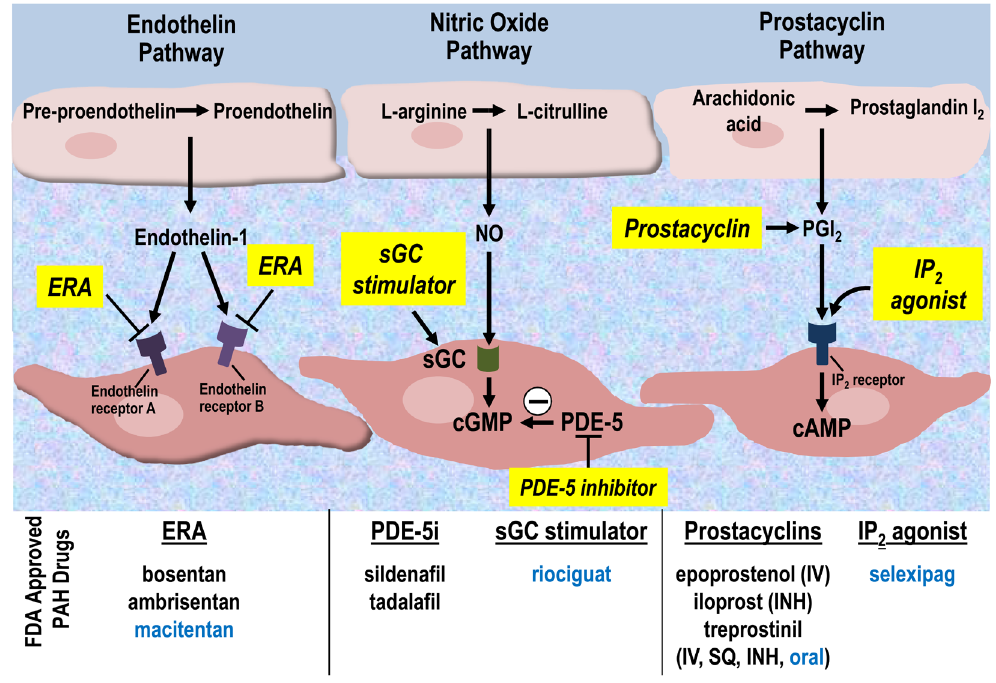
Figure 1. Pathways targeted in current therapies for pulmonary arterial hypertension. Newly approved therapies are listed in blue. cAMP, cyclic adenosine monophosphate; cGMP, cyclic guanylate monophosphate; ERA, endothelin receptor antagonist; FDA, US Food and Drug Administration; INH, inhaled; IP , prostacyclin receptor 2; IV, intravenous; NO, nitric oxide; PAH, pulmonary arterial hypertension; PDE-5, 2 phosphodiesterase-5; PDE-5i, phosphodiesterase-5 inhibitor;